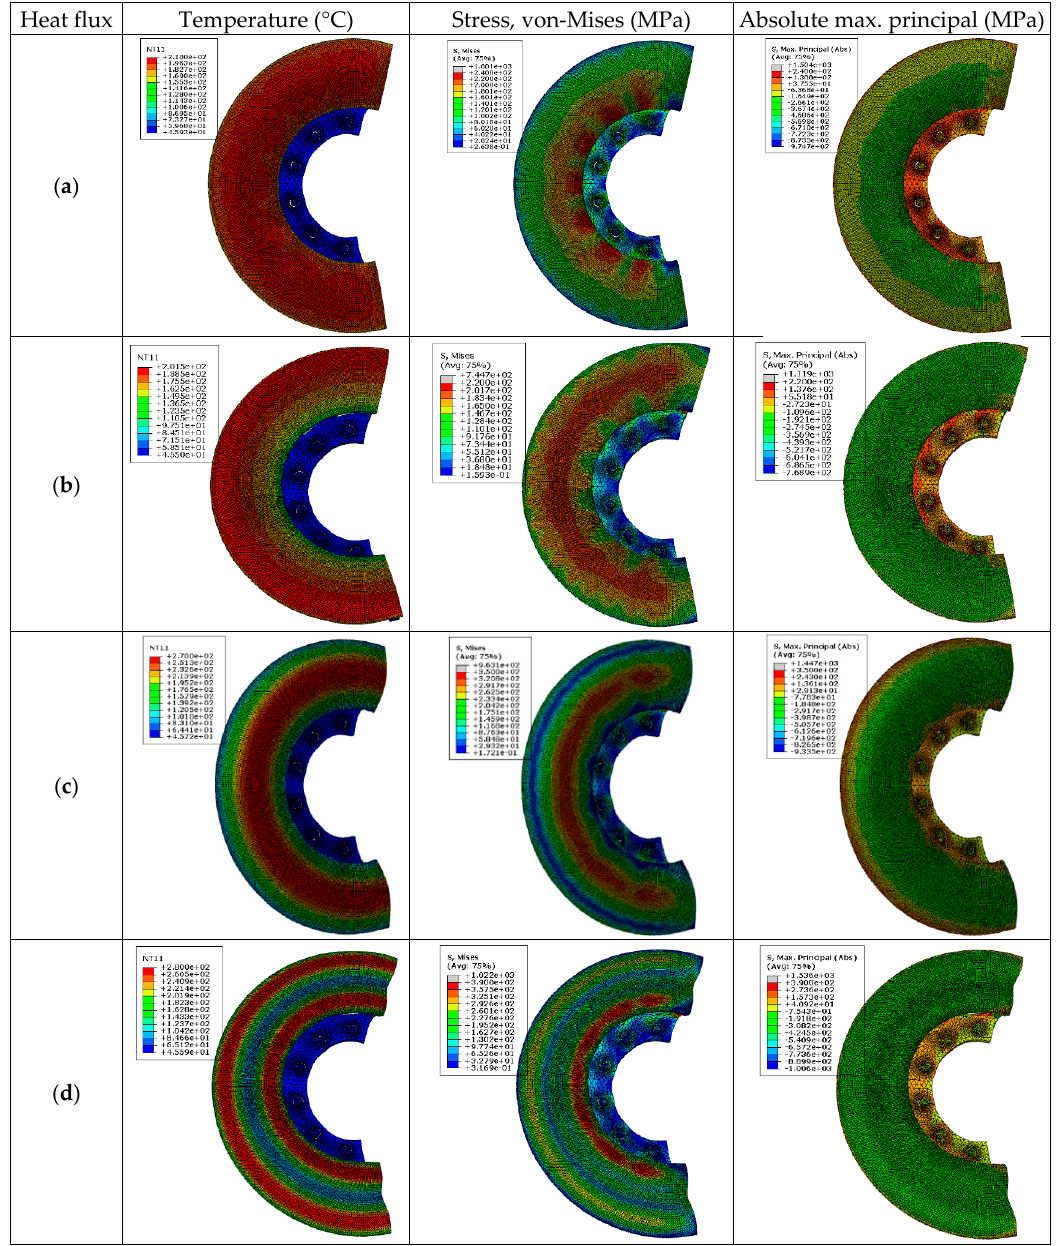
Figure 6. Thermal and stress fields at t = 16.26 s after brake application. ( a ) Uniform, ( b ) Linear, ( c ) Quadratic, ( d ) Quartic.